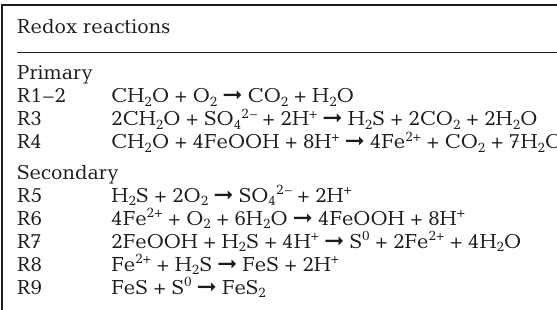
Table 2. Idealized set of biogeochemical reactions (R1 to R9). R1 and R2 represent the same redox reaction, i.e. oxic